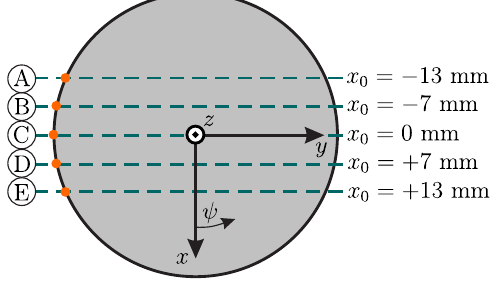
Figure 8. Schematic representation of five exemplary scanning trails ( A – E